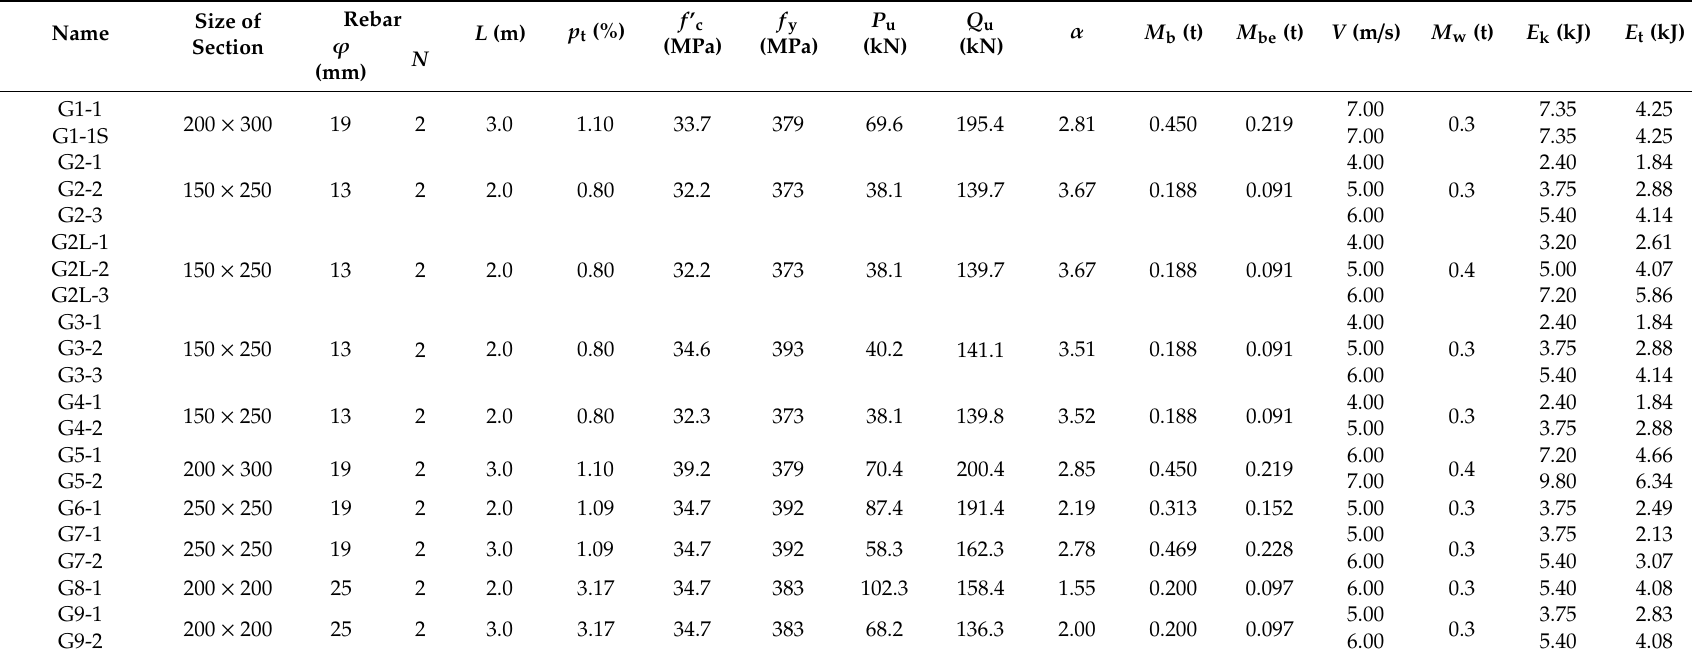
Table 1. List of test specimens used for analysis